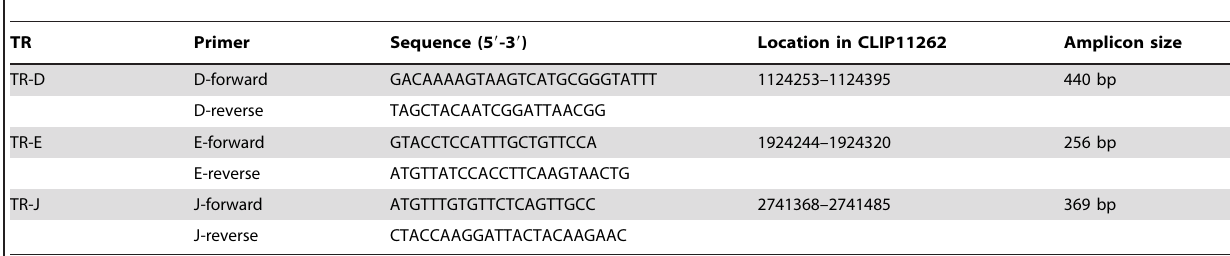
Table 2. Primer sets for MLVA